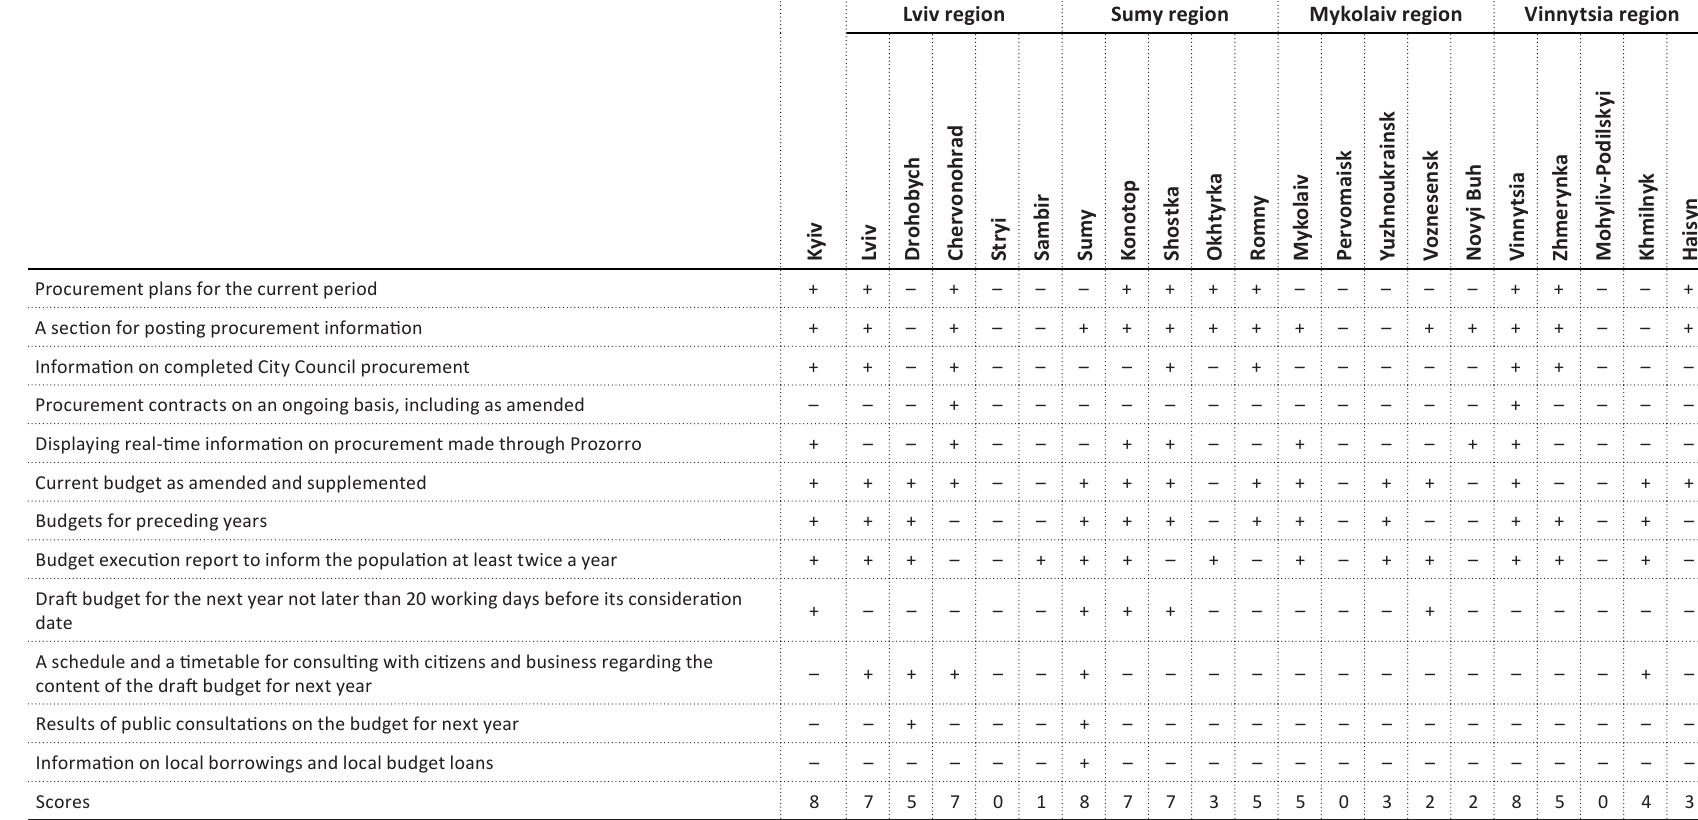
Lviv region Sumy region Mykolaiv region Vinnytsia